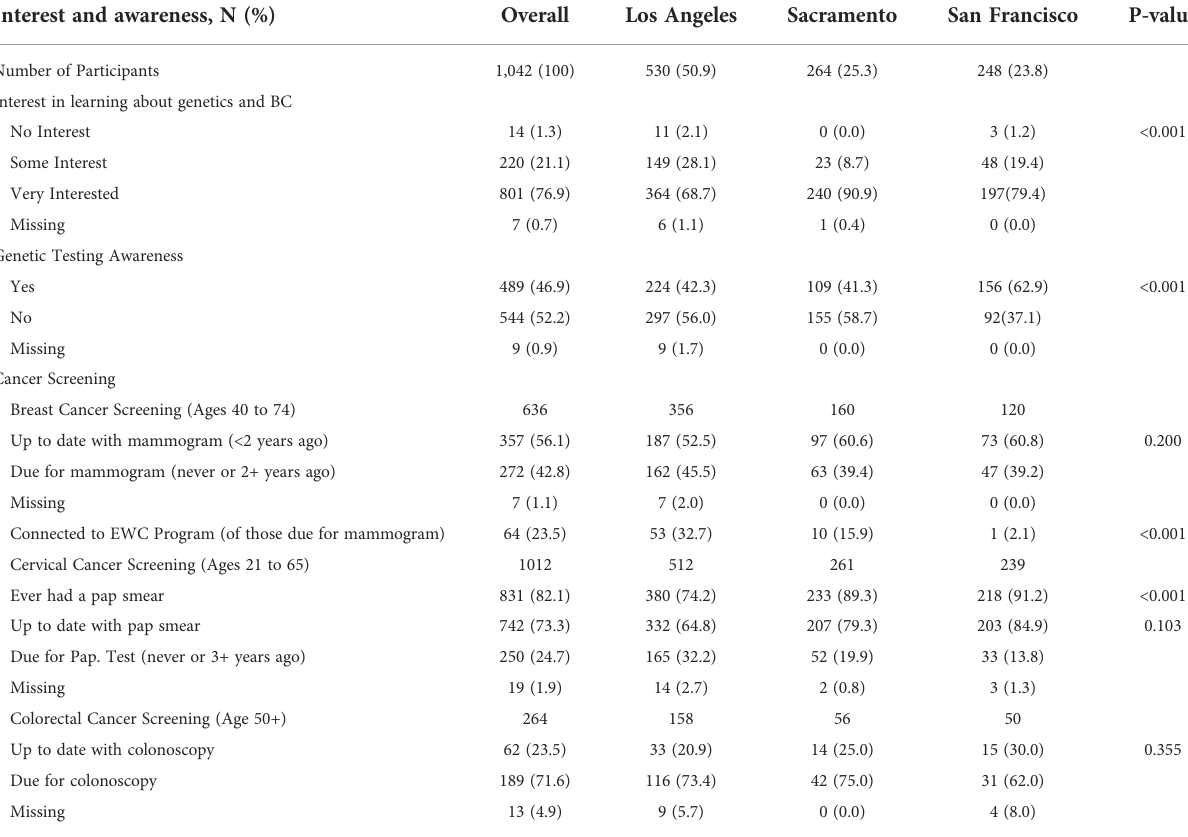
TABLE 2 Screening behavior and interest in breast cancer genetics among ‘ Tu Historia Cuenta ’ study participants (N=1,042) overall and by recruitment